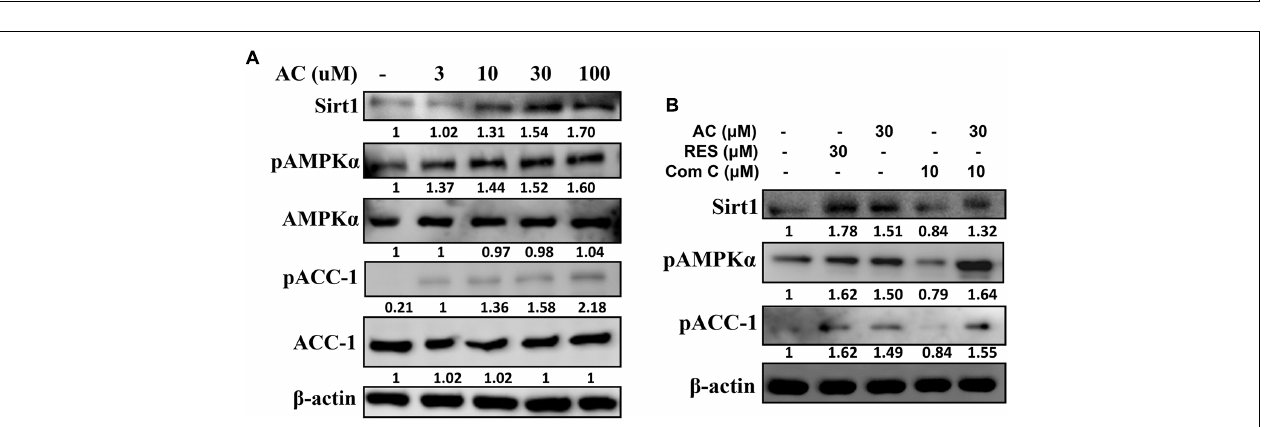
FIGURE 4 | The effect of acacetin (AC) (3–100 µ M) on the AMPK pathway in 3T3-L1 cells. (A) Differentiated 3T3-L1 adipocytes were treated with acacetin for 24 h, and the protein expression of Sirt1, phosphorylated AMPK α (pAMPK α ), AMPK α , phosphorylated ACC-1 (pACC), and ACC-1 was determined using Western blot analysis ( n = 3). AMPK α or ACC-1 was used as an internal control. (B) Cells were cultured with acacetin plus the AMPK inhibitor compound C (Com C), and AMPK phosphorylation and Sirt1 and ATGL protein expression were assessed. Resveratrol (RES) was used as the sirt1 positive control. β -actin was used as an internal